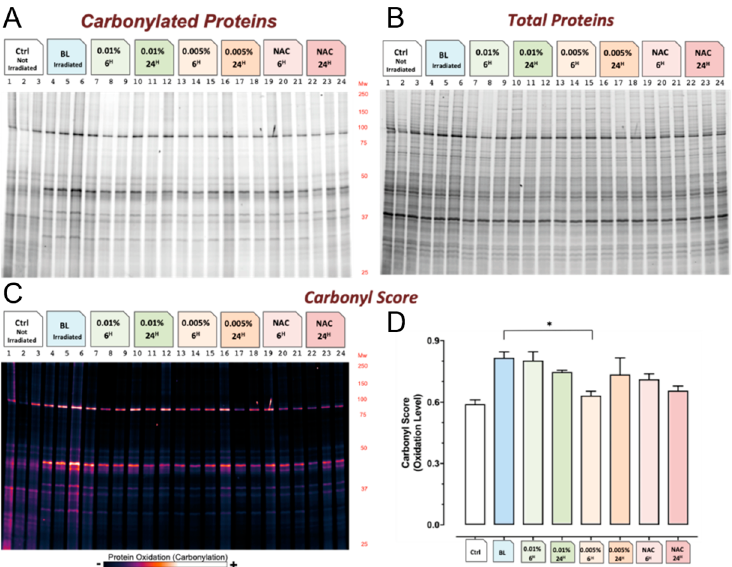
Figure 3. Protein quantification and carbonyl score. Quantification of carbonylated ( A ) and total ( B ) proteins. The levels of protein carbonylation for each experimental condition are represented as a continuous intensity histogram ( C ) and plotted as vertical bar representation with standard error from the average values ± standard deviation ( D ). * Significantly di ff erent from stressed experimental group ( p <